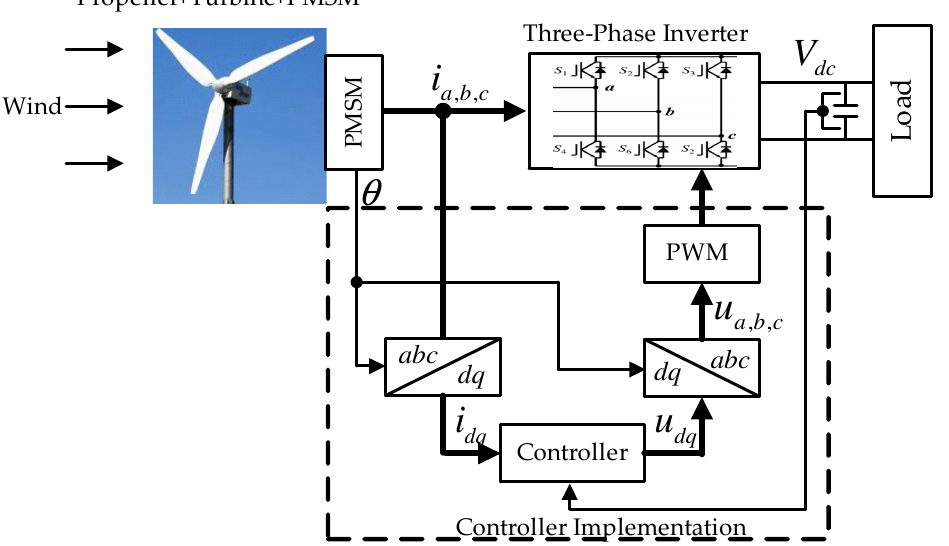
Figure 2. Closed-loop system